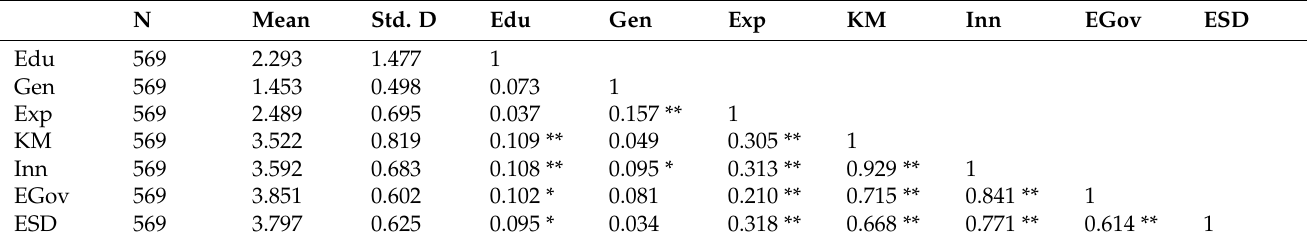
Table 3. Descriptive statistics, mean, standard deviation, and correlations between